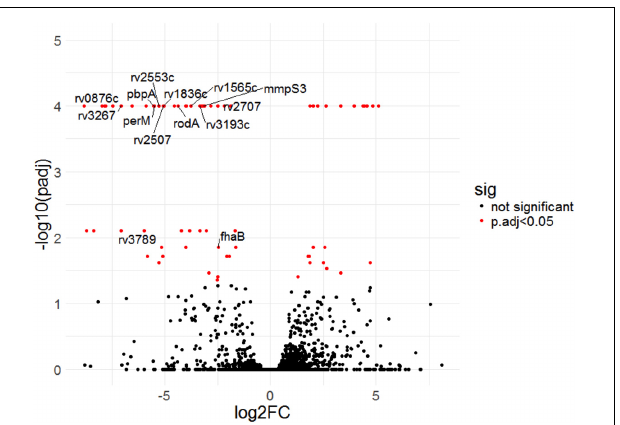
FIGURE 5 | Transposon sequencing (Tnseq) experiments revealed rv0954 ’s genetic interactions with genes encoding integral membrane proteins. Log2 fold change of transposon insertions in WT and the (cid:49) rv0954 mutant ( (cid:49) rv0954/ WT ) plotted against adjusted p -values for each genetic locus. Loci with an adjusted p -value of < 0.05 are colored in red. The dataset was generated from biological duplicates. Annotations of each genetic locus are from publicly available databases PATRIC (https://www.patricbrc.org/) and FLUTE (http://orca2.tamu.edu/U19/). The significantly underrepresented hits encoding integral membrane proteins are indicated by name or gene number.